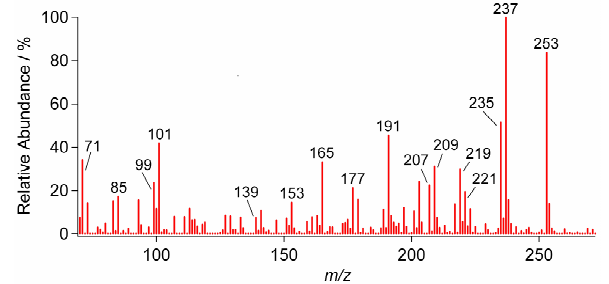
Figure 14. An example mass spectrum, recorded using CIR-TOF-MS during ACES photo-2 Fig. 14. An example mass spectrum, recorded using CIR-TOF-MS oxidation experiment 03-07-08. The data show the relative abundances of signals integrated 3 during ACES photo-oxidation experiment 03-07-08. The data show over the entire experiment. For clarity, signals due to reagent E -caryophyllene have been 4 the relative abundances of signals integrated over the entire experi- subtracted. 5 ment. For clarity, signals due to reagent β -caryophyllene have been